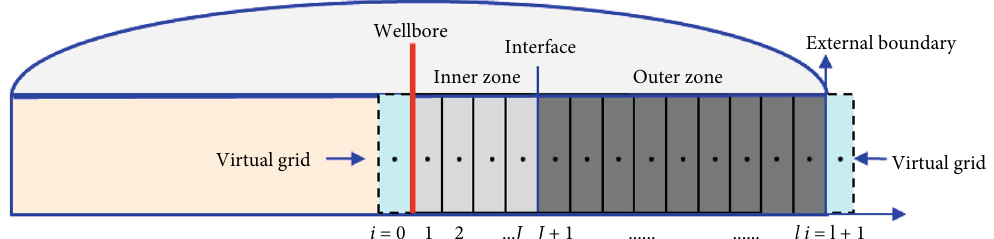
Figure 4: Discrete grid diagram of circular compound